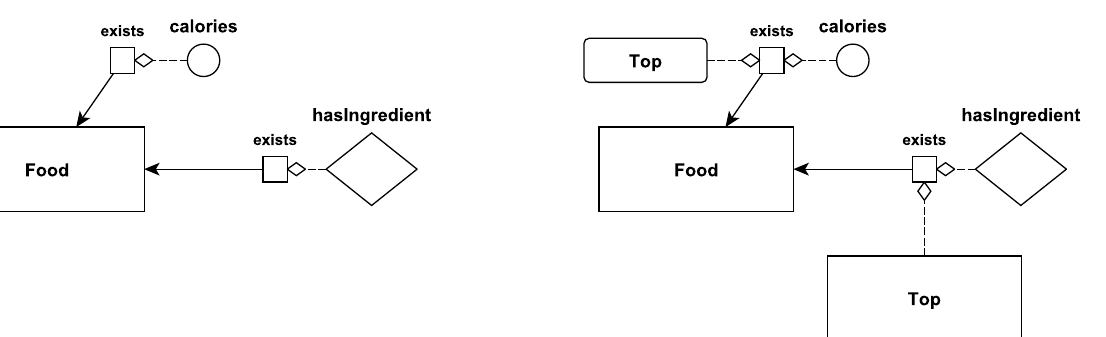
Figure 3. Example of a disjoint concept hierarchy represented in G RAPHOL with ( left-hand side figure ) and without ( right-hand side figure ) the disjoint union node.